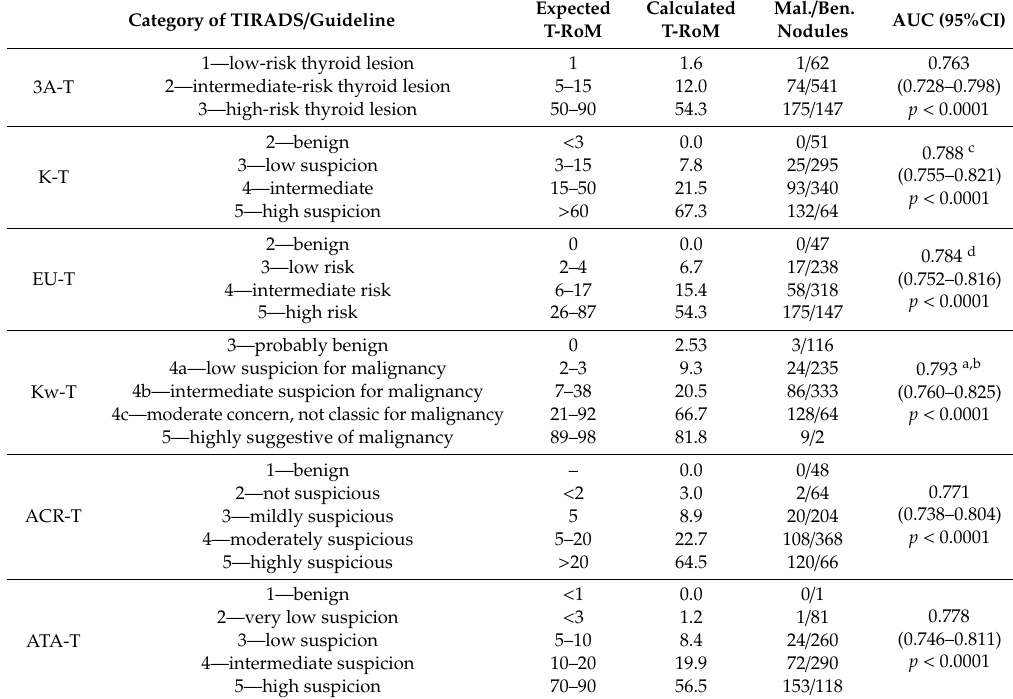
Table 2. Distribution of benign and malignant nodules between particular categories of Thyroid Imaging Reporting and Data Systems (TIRADS), the comparison of expected T-ROM with calculated T-ROM for each TIRADS and diagnostic e ffi cacy of evaluated TIRADS as measured with AUC (TIRADS categories corresponding to the lack of nodules have been